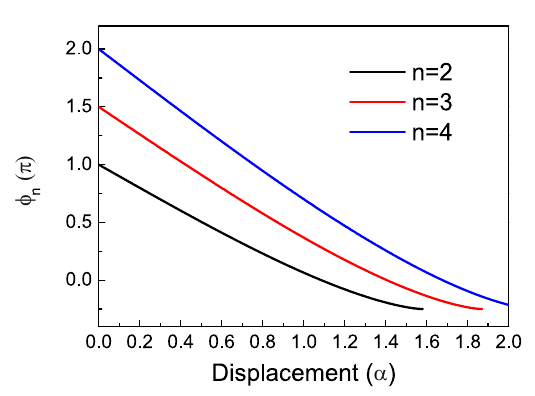
Figure 2. A simple mode of a displaced squeezed state and a n-photon number state in phase space. The circular band represents the n-photon number state. The ellipse represents the DSS. The overlaps correspond to two interfering complex-valued probability amplitudes. The phase for one probability amplitude is fixed by the pink shaded domain caught by the central lines of two states.